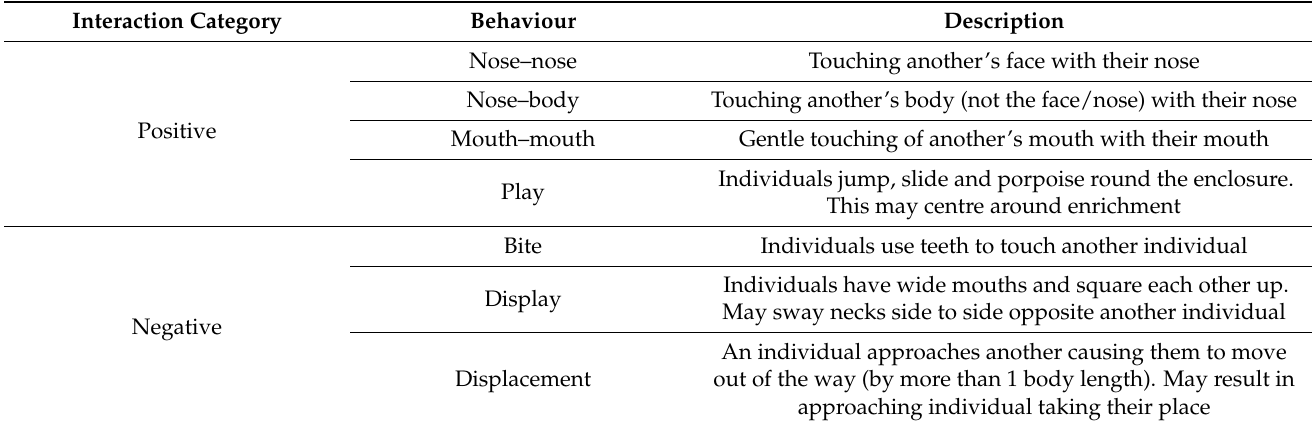
Table 2. Ethogram detailing positive and negative behaviours recorded during the study. Ethogram was based on [25], and modified during preliminary observations prior to commencement of the